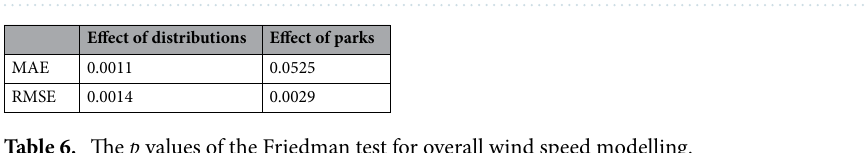
Figure 3. The overall RMSE of wind speed PDFs for NWP data from five sites and measurements from Fakken.